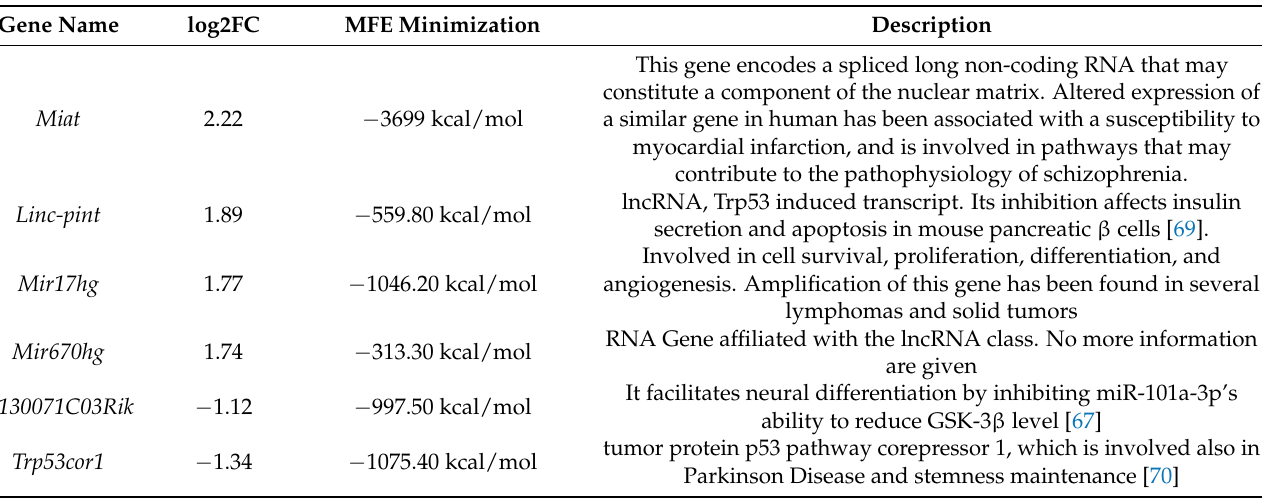
Table 3. Summary of lncRNAs with a human homologue. Columns report gene name, log2FC, MFE minimization according to the secondary structure prediction and description. Descriptions were taken from literature and ncbi gene bank (https://www.ncbi.nlm.nih.gov/gene/ (accessed on 25 February